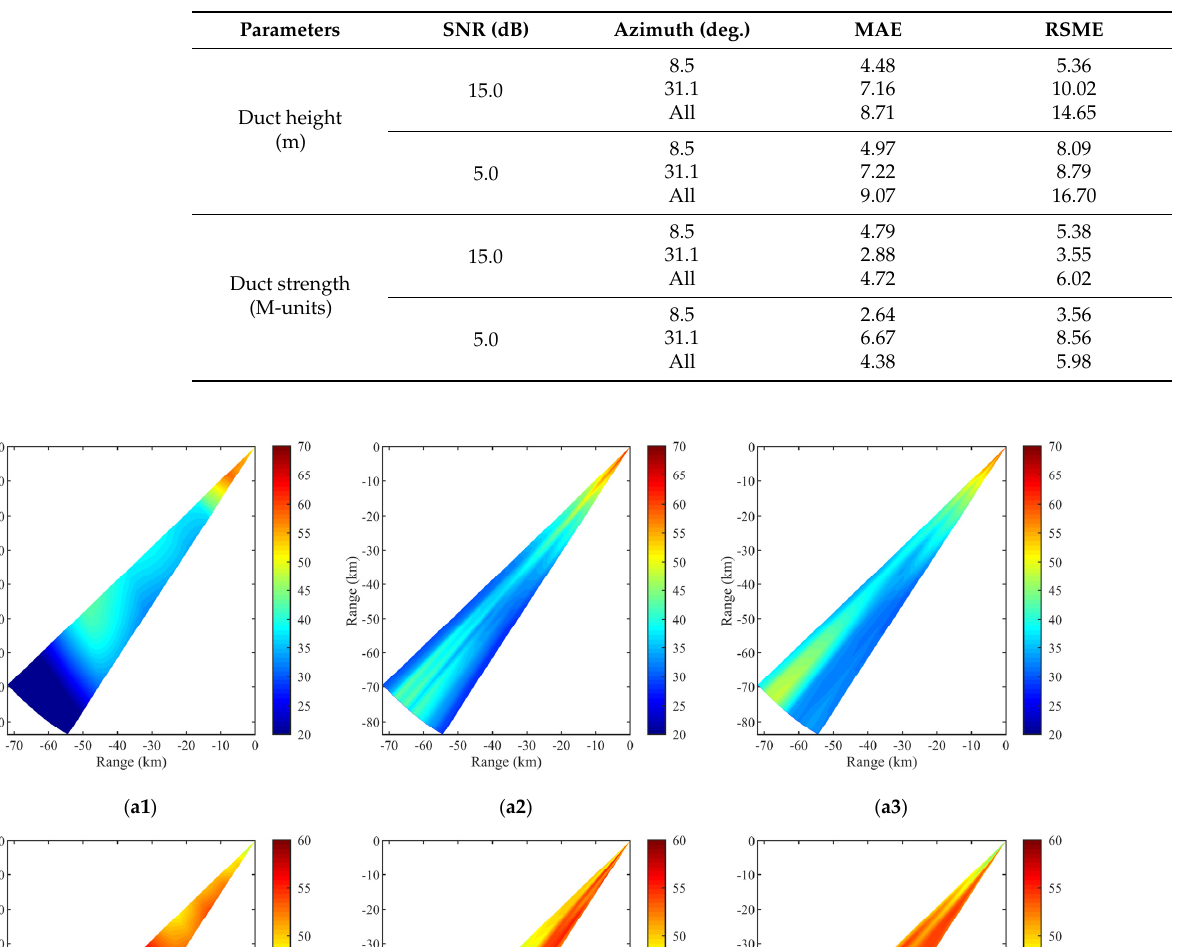
Table 2. The inversion errors at different satellite elevation angle and SNR cases.